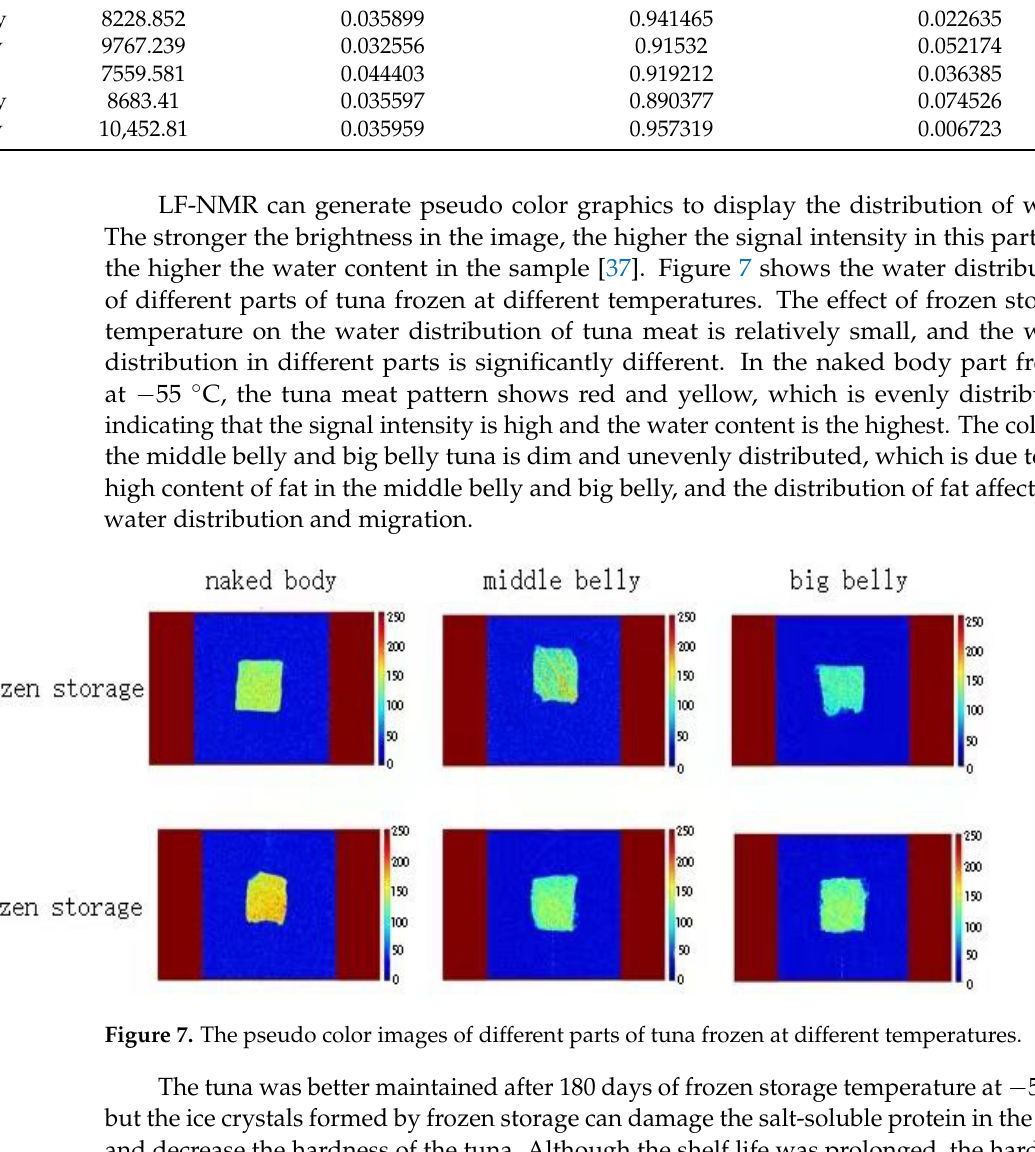
Figure 7. The pseudo color images of different parts of tuna frozen at different temperatures.